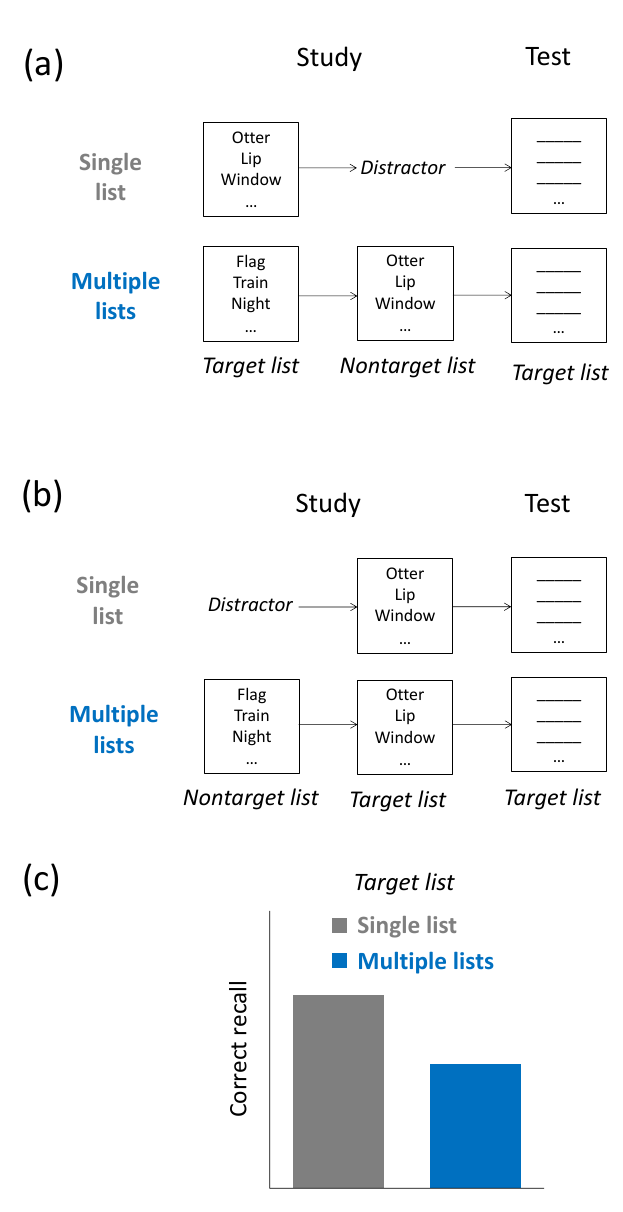
Figure 2. Multiple-list learning. ( a , b ) Retroactive-interference version ( a ) and proactive-interference version ( b ) of the task: Participants study a target list, which may consist of unrelated items. Study of the target list is either followed ( a ) or preceded ( b ) by unrelated distractor activity or the study of one or several additional (nontarget) lists. ( c ) Typical results: In both the retroactive-interference and proactive-interference versions of the task, target-list recall is typically impaired in the presence of additional nontarget